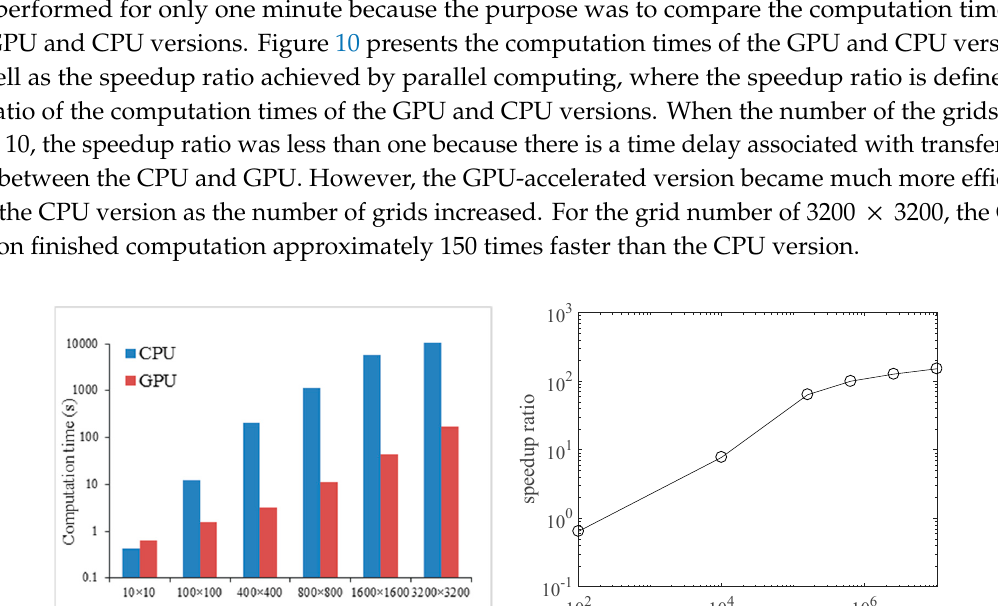
time (s), ( b ) speedup ratio. (s), ( b ) speedup